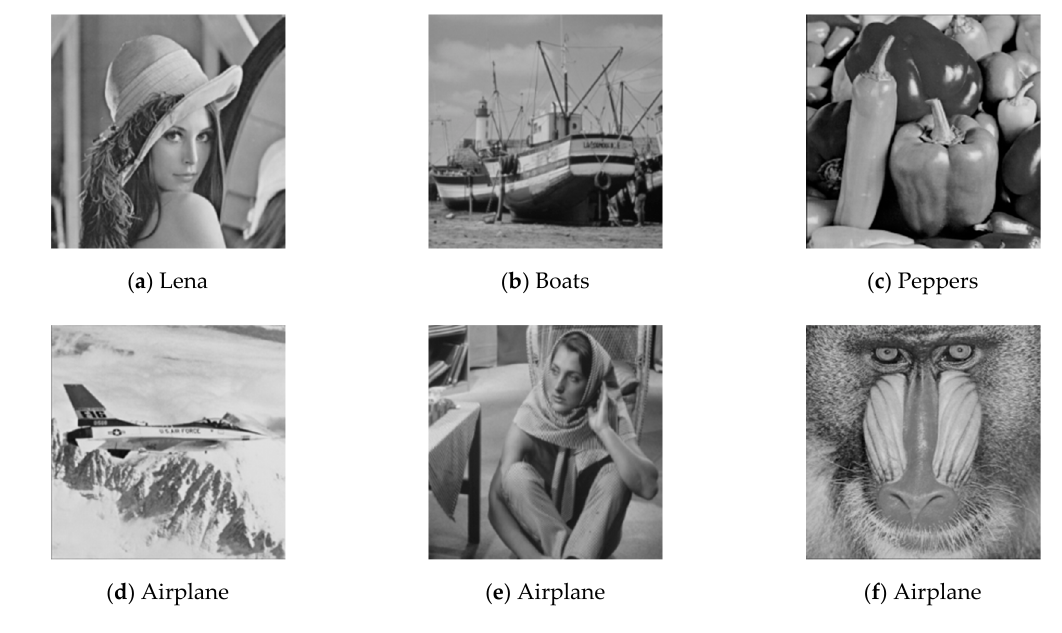
Figure 7. Six test images.